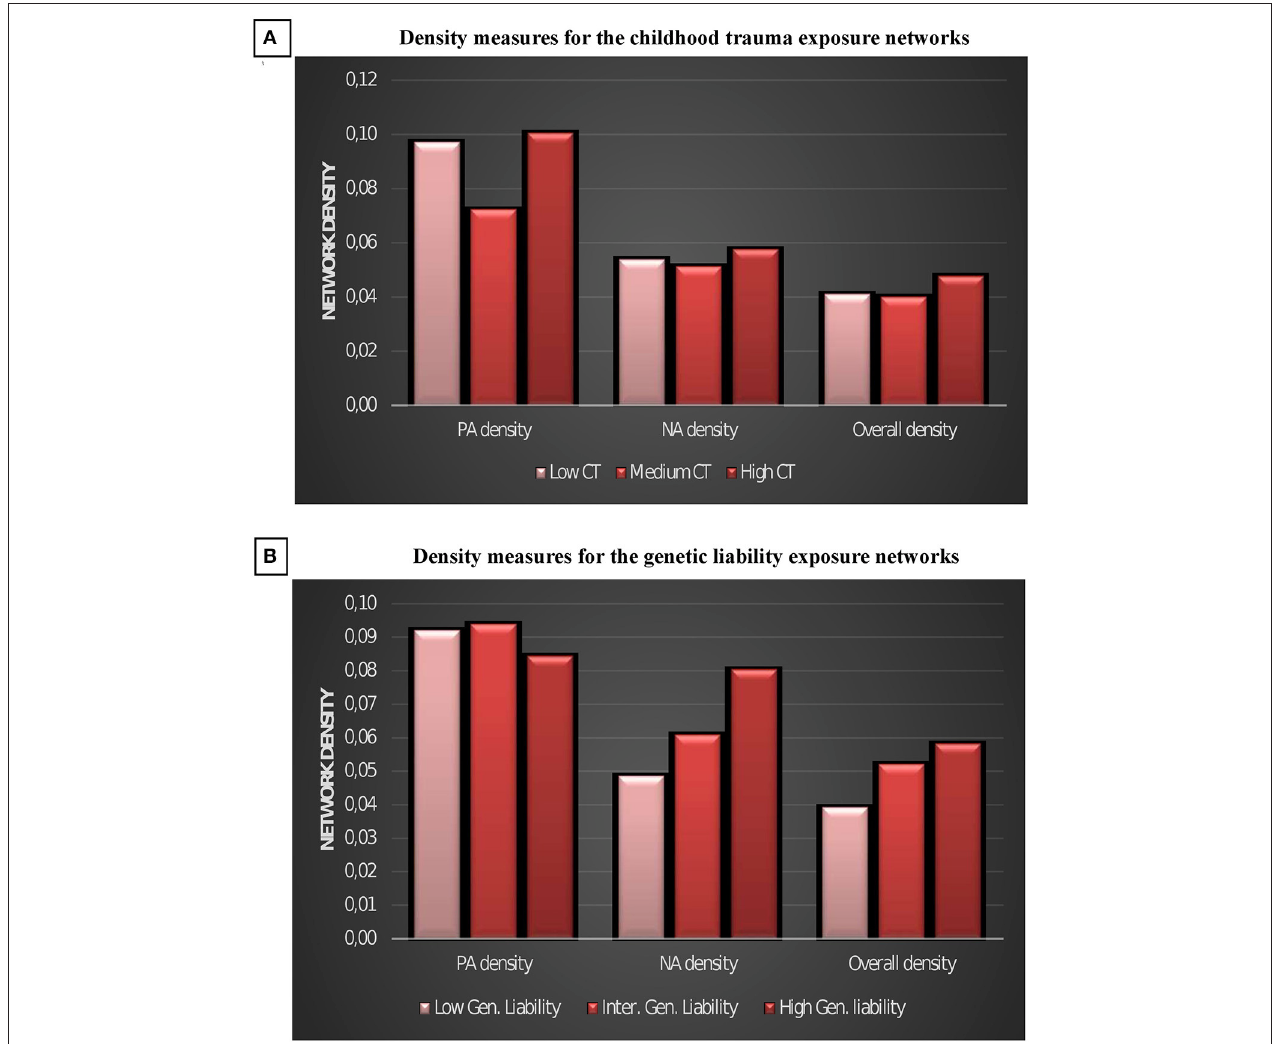
FIGURE 3 | Density measures for the childhood trauma exposure emotions networks (A) and for the genetic liability emotions networks (B) . CT, childhood trauma; GL, Genetic liability; NA, negative affect; PA, positive